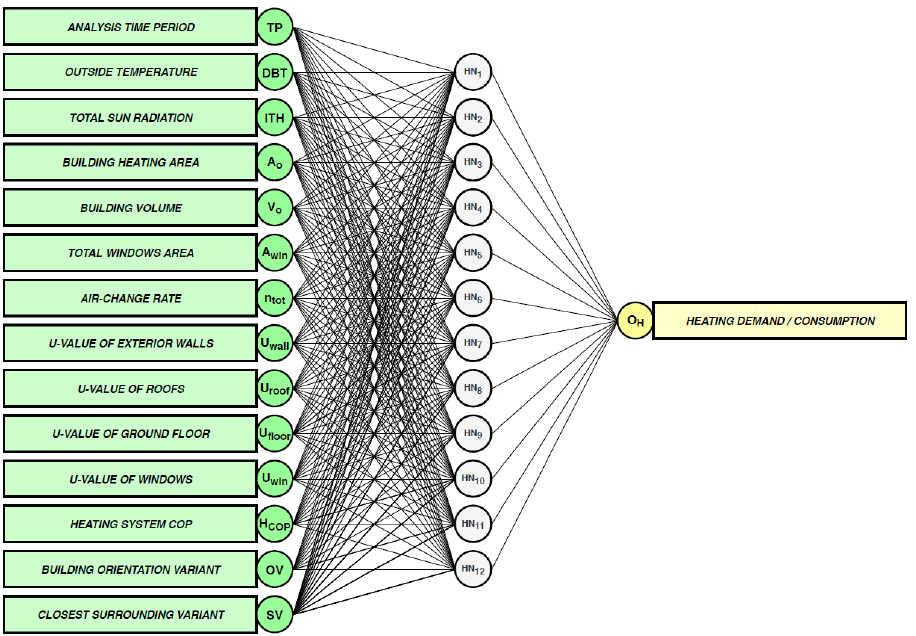
Figure 3. The structure of the defined ANN.